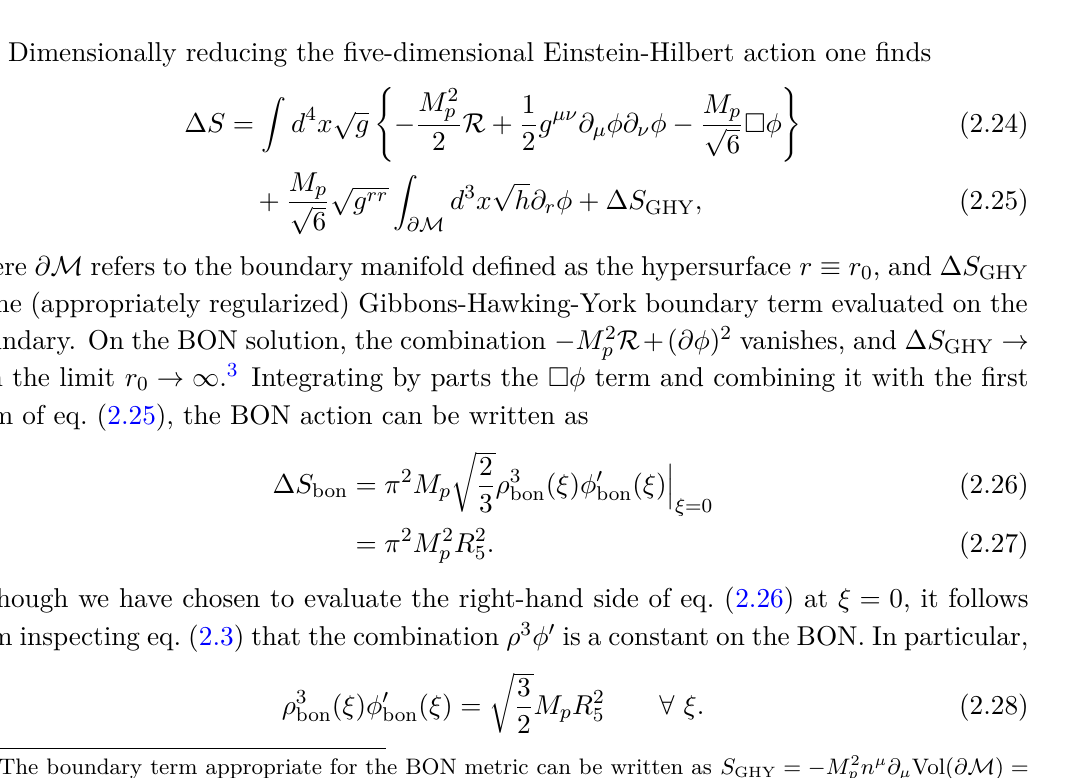
( ξ ) ( left ) and ρ ( ξ ) ( right ) of the corresponding bon bon ) and asymptotic ( ξ (cid:29) R ) 5 5